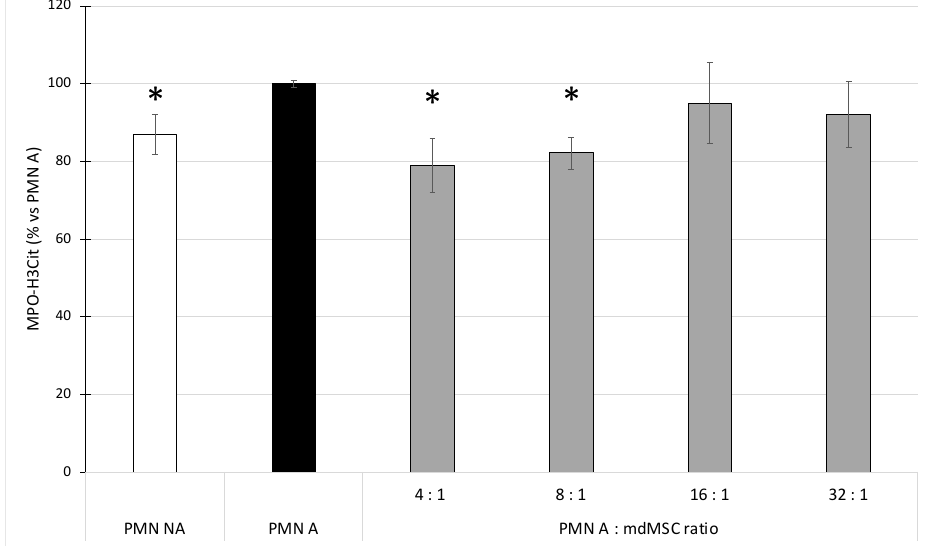
Figure 5. Effect of non-activated (PMN NA) and CB/fMLP-activated neutrophils (PMN A) alone or in coculture with mdMSCs at different ratios (PMN A:mdMSC ratio) on H3Cit associated to MPO-DNA complexes of the NET. Results from 5 independent experiments ( n = 5) with 2 technical replicates for each point, including 4 horses for mdMSCs and 5 horses for neutrophils. Means ± SD are shown in relative percentages versus stimulated neutrophils without mdMSCs (PMN A) defined as 100% response. Statistical analysis was considered for 5 independent experiments * p < 0.05 vs. PMN A.